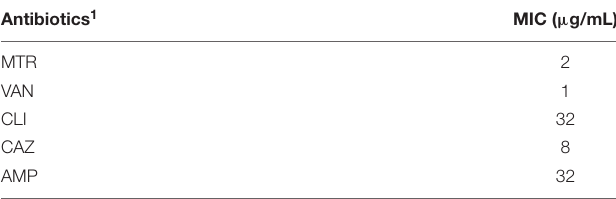
TABLE 1 | Minimal inhibitory concentration (MICs) of the five